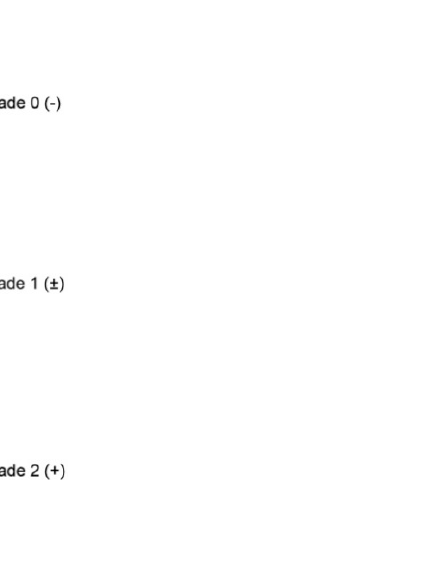
Figure 1. Detection of total IgE in nasal fluid using the AW test: ( A ): Grade 0. ( B ): Grade 1. ( C ): Grade 2.